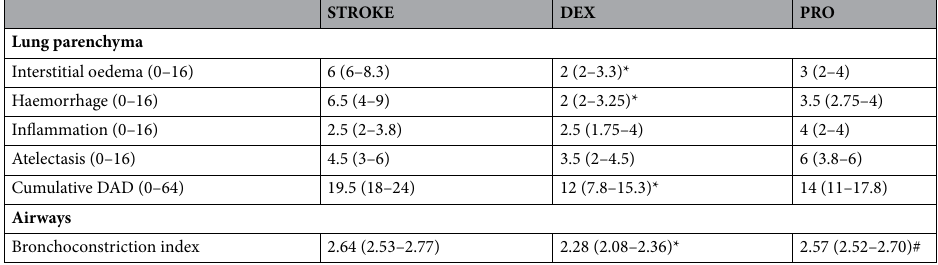
modulating the binding properties of glutamate receptors and the uptake of glutamate 3 . However, propofol may lead to neurotoxicity effects in traumatic brain injury 7 .